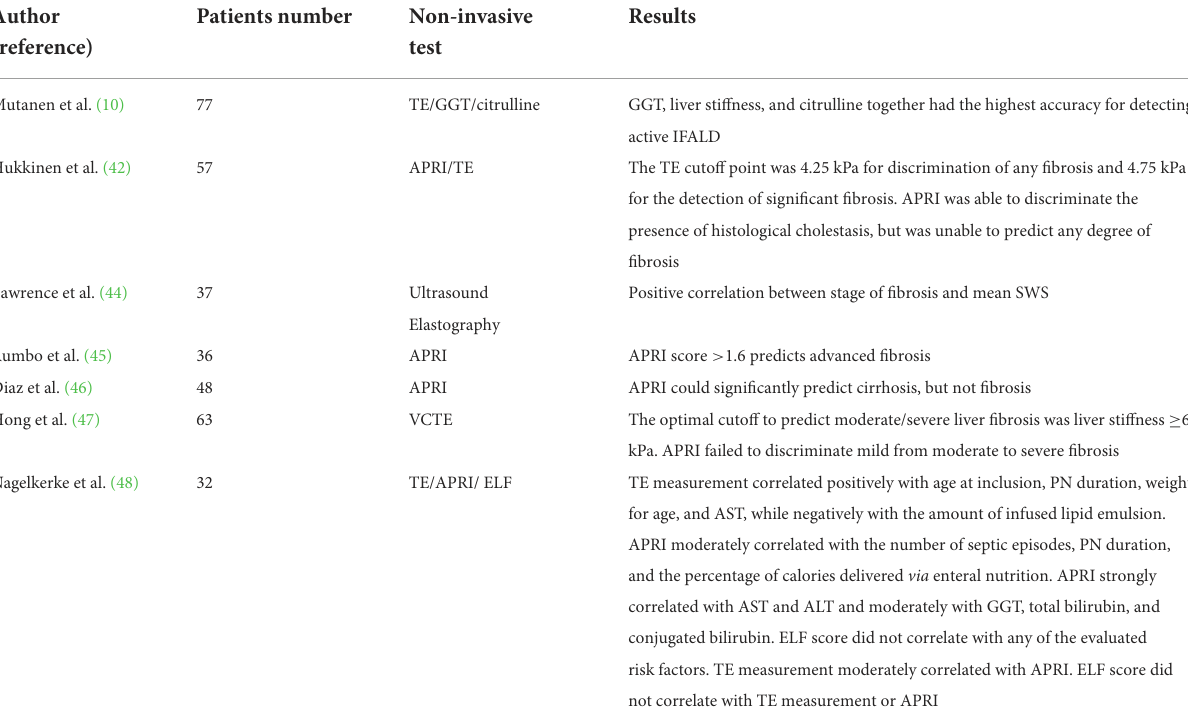
TABLE 1 Non-invasive tests for diagnosis and monitoring of IFALD in